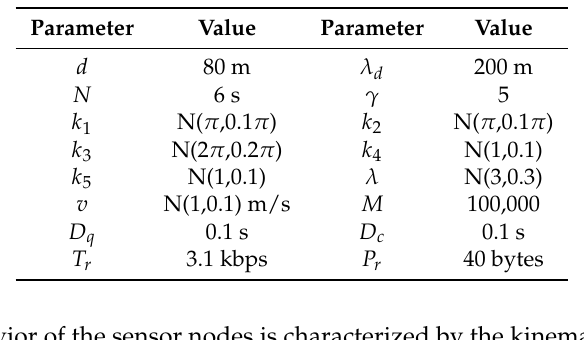
Table 1. Simulation